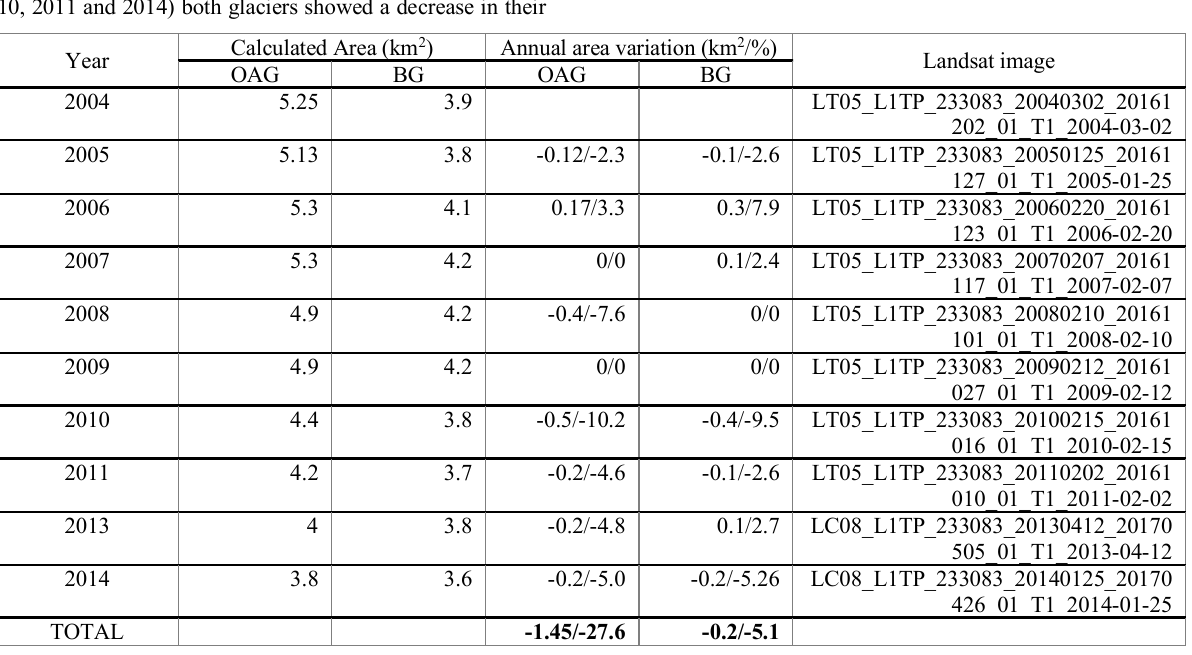
Table 2. Calculated areas (km 2 ) and annual area variations (km 2 /%) for the studied glaciers. Right column lists the used Landsat images in each